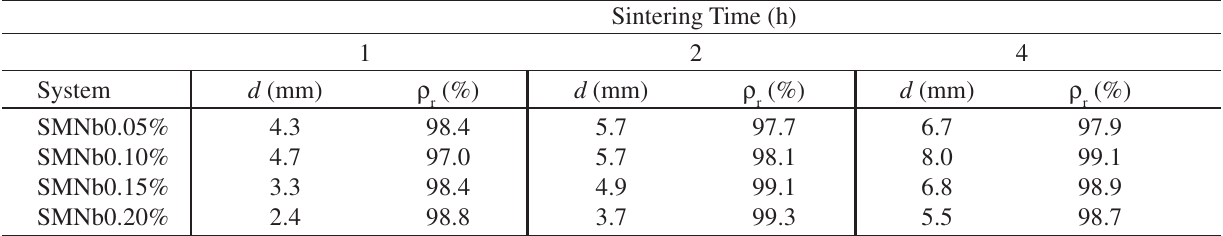
) for the SnO .MnO -based varistor system with varying sintering r 2 2